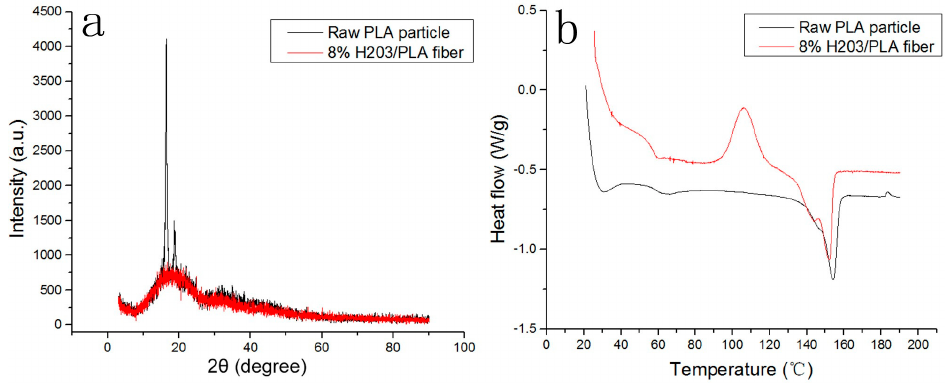
Figure 5. XRD scan ( a ) and DSC curve ( b ) for raw PLA particle and (8% H203)/PLA fiber.